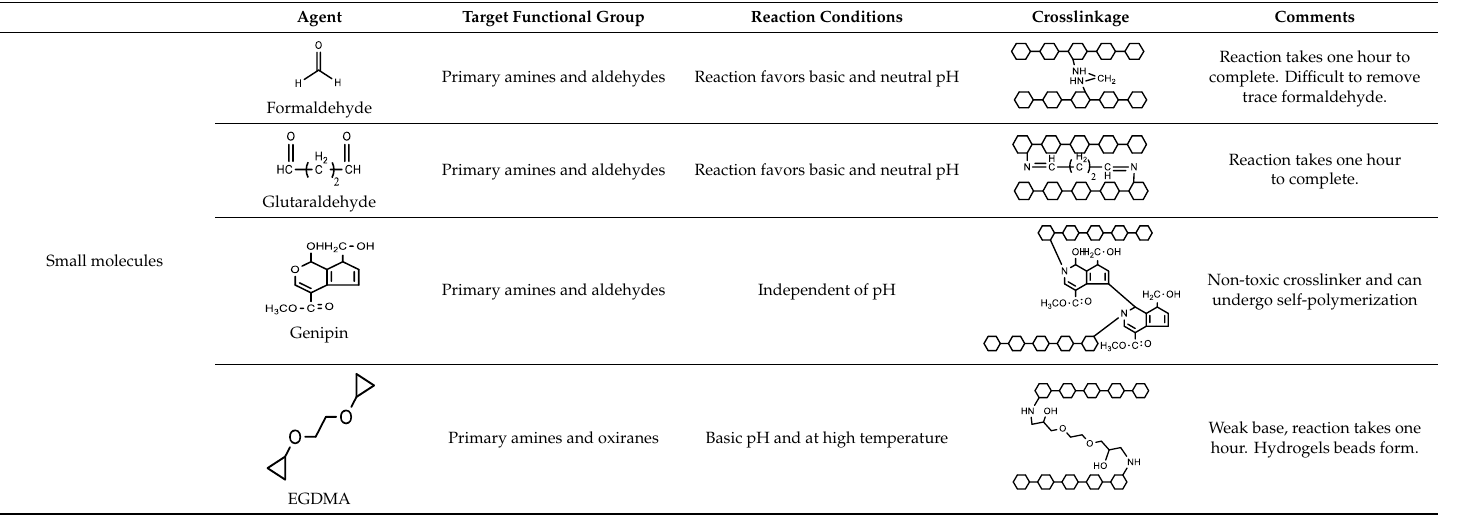
Table 1. Crosslinking of polymers through small molecules.